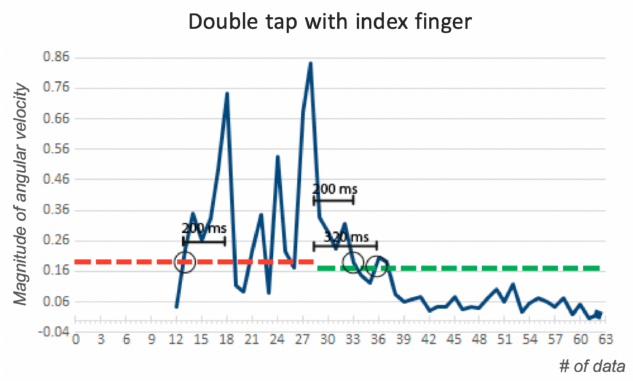
Figure 3. Estimating the end of the gesture. A peak is detected and eliminated at the end of the signal to avoid movements not associated with the gesture. The final signal, of 800 ms, goes from data point 13 to